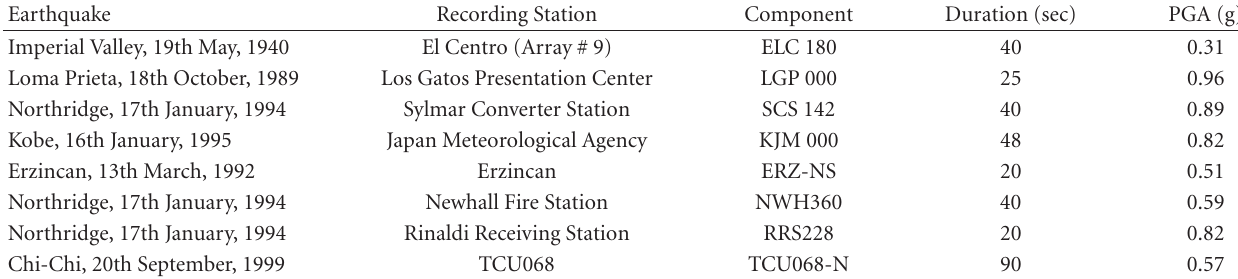
Table 1: Details of earthquake motions considered for the numerical study.